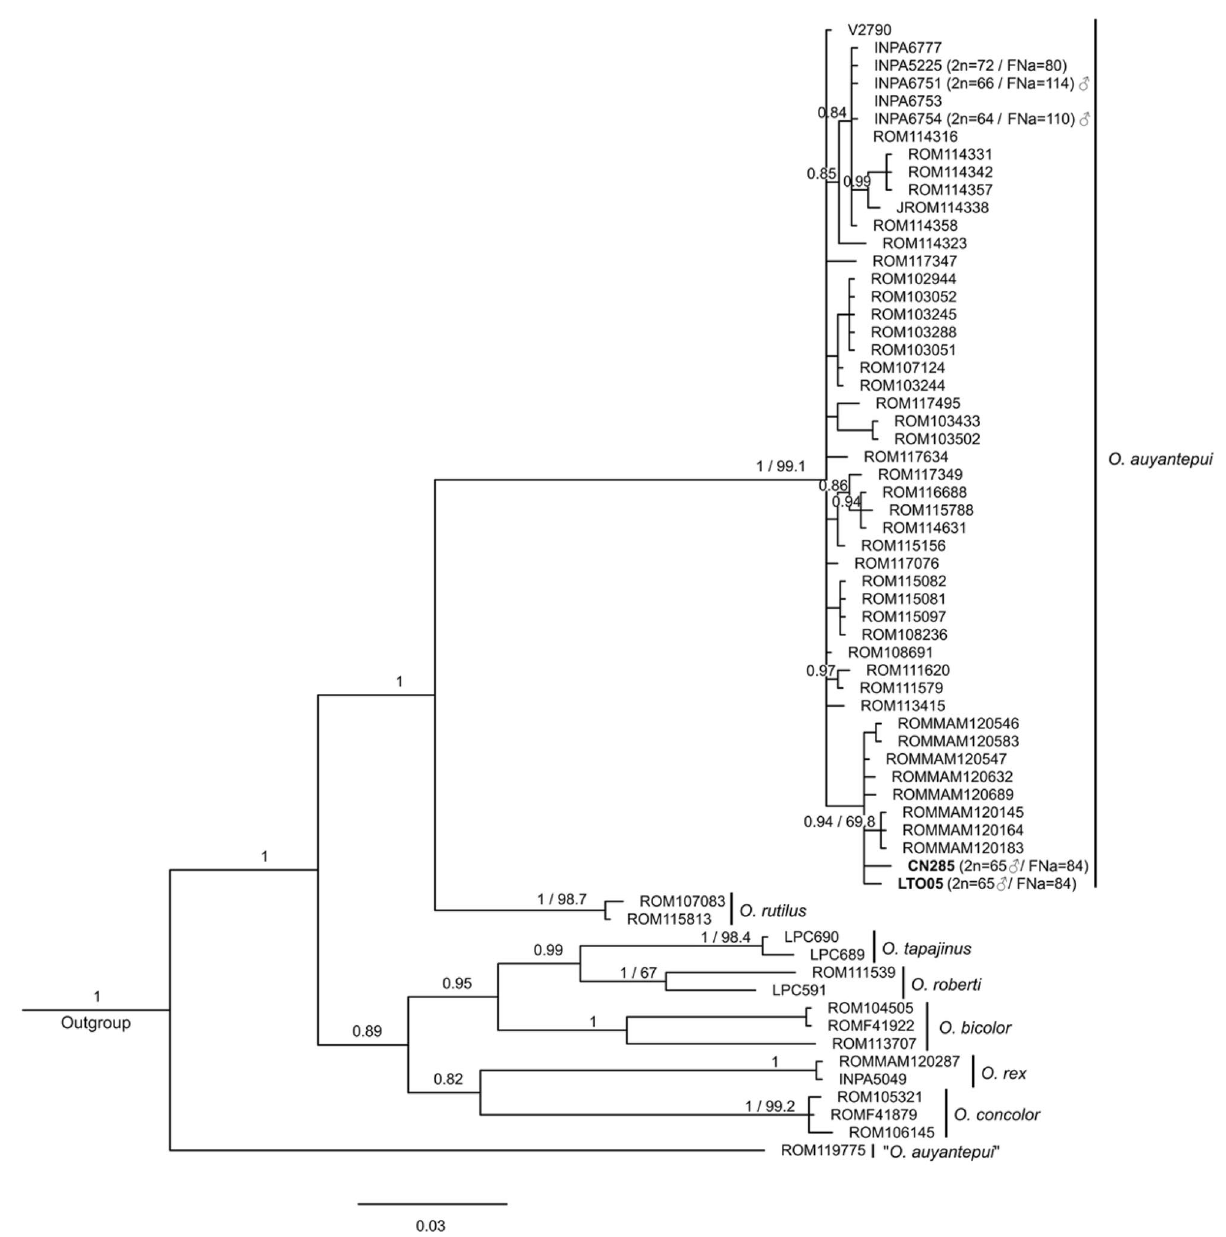
Figure 4. Bayesian Inference topology based on Cytochrome C Oxidase Subunit I. The numbers above branches indicate posterior probability values for Bayesian Inference analysis (only values > 0.80 are shown) and bootstrap values for Maximum Likelihood analysis (only values > 65% are shown). Bold numbers indicate the samples from this study. Sample data are provided in Supplementary Table